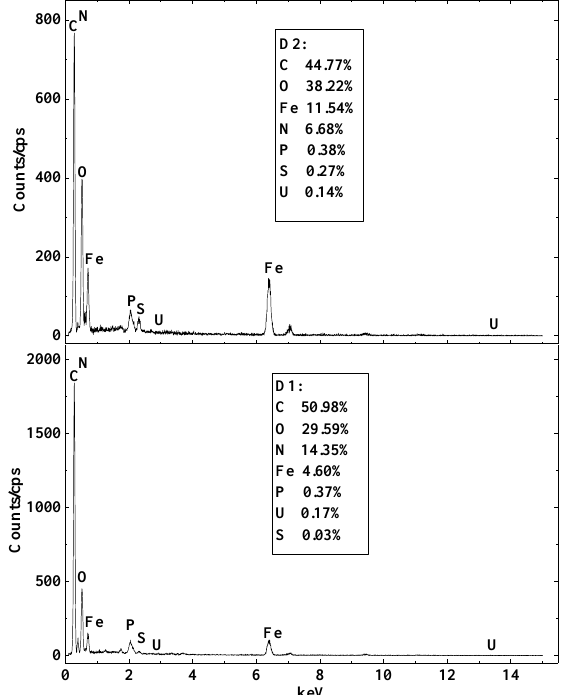
Figure 6. EDS analysis of the Clostridium sp. PXL2 sediment (corresponding to spots D1 and D2 in Figure 5). Typical spectra are shown from one of triplicate determinations.